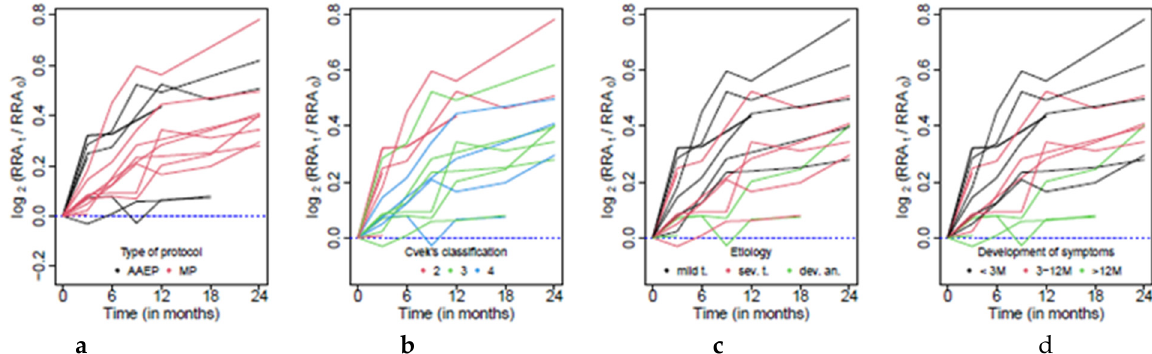
Figure 5. Graphical representation of RRA change in time in view of the ( a ) Type of protocol; ( b ) Cvek’s classification; ( c ) Etiology; ( d ) Time of development of